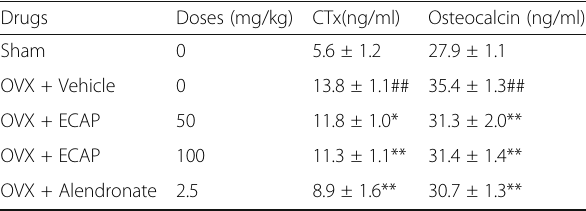
Table 2 Effects of ECAP on plasma CTx and Osteocalcin contentrations in OVX mice